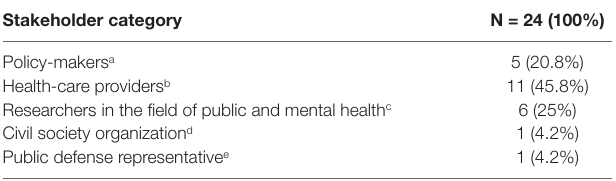
TaBle 1 | A profile of the stakeholders who participated in the policy dialogue. Stakeholder category n = 24 (100%) Policy-makers